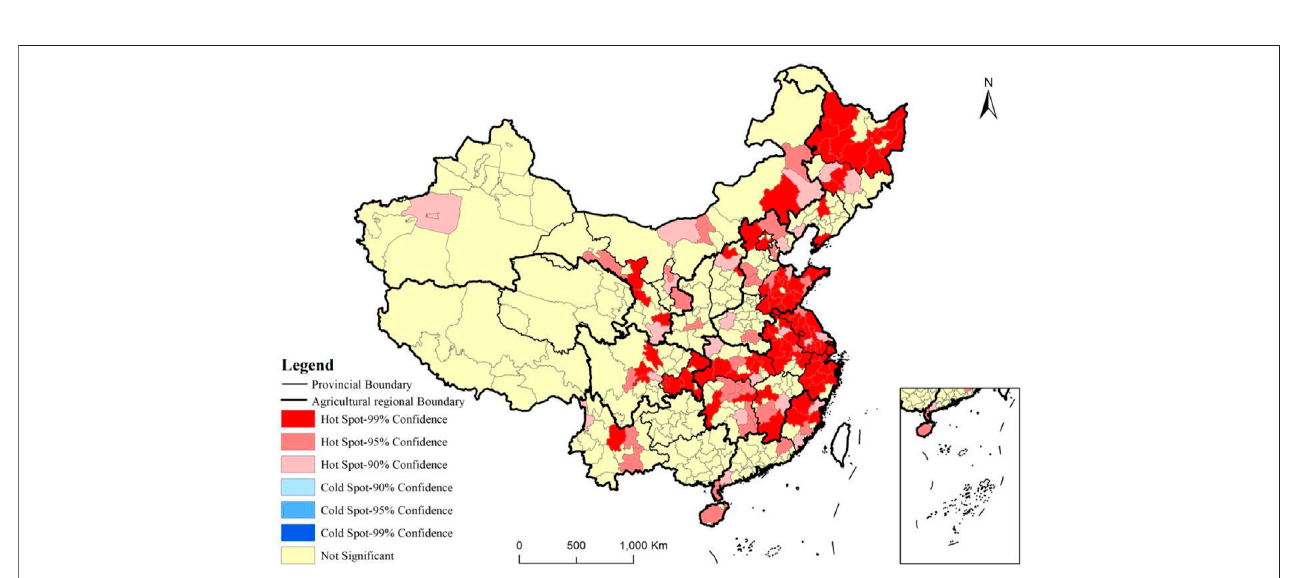
FIGURE 2 | Spatial aggregation of the overall green food